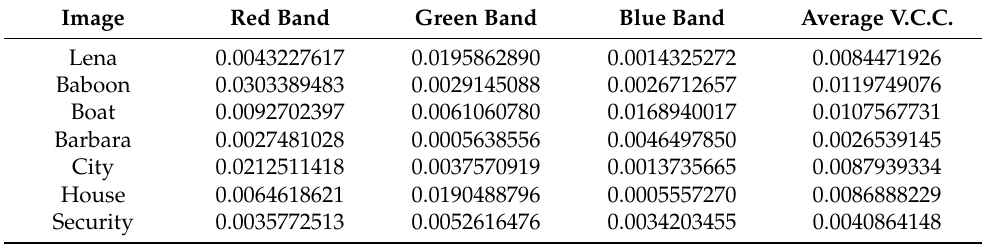
Table 5. Vertical correlation coefficient results.